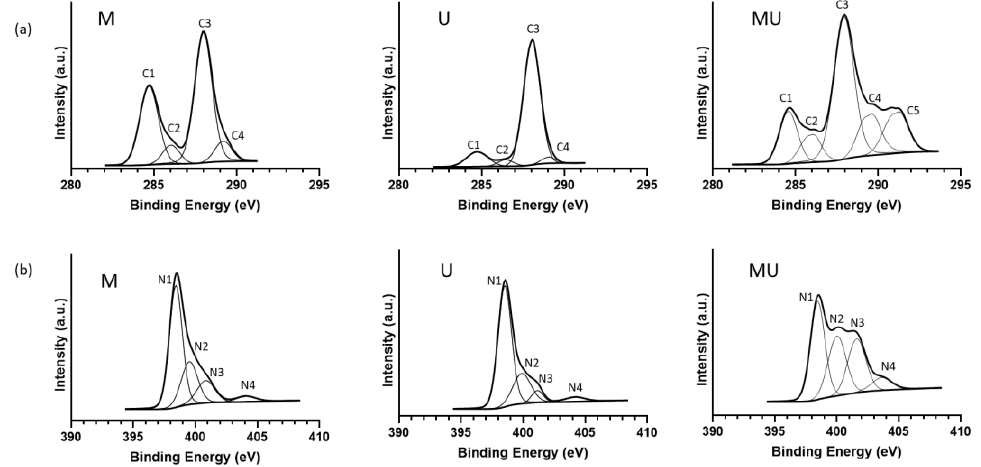
Figure 4. XPS spectra for C 3 N 4 powder prepared from 24·10 −3 mol precursor Melamine (M), Urea (U), and mixed precursor (MU): ( a ) C1s and ( b ) N1s. (U), and mixed precursor (MU): ( a ) C1s and ( b )